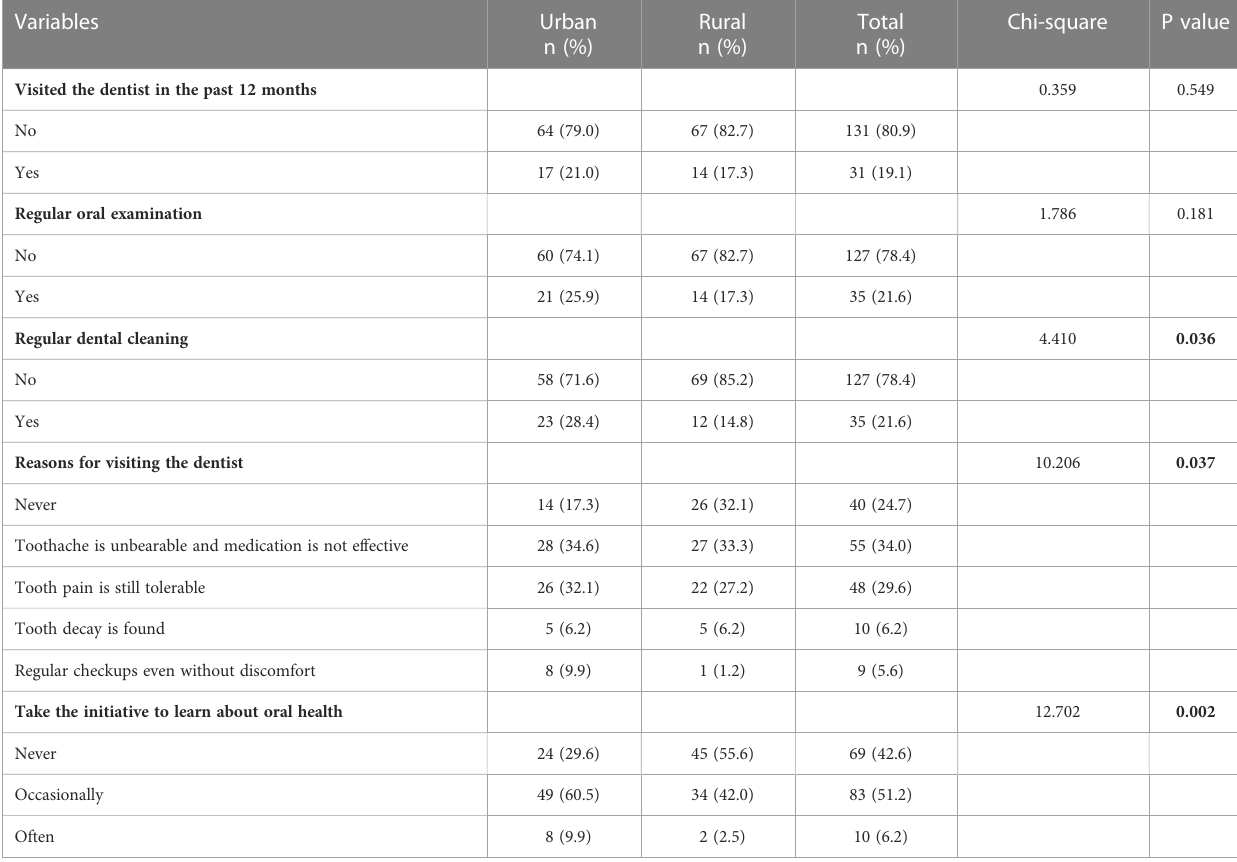
TABLE 3 Oral health service utilization between urban and rural cancer patients.